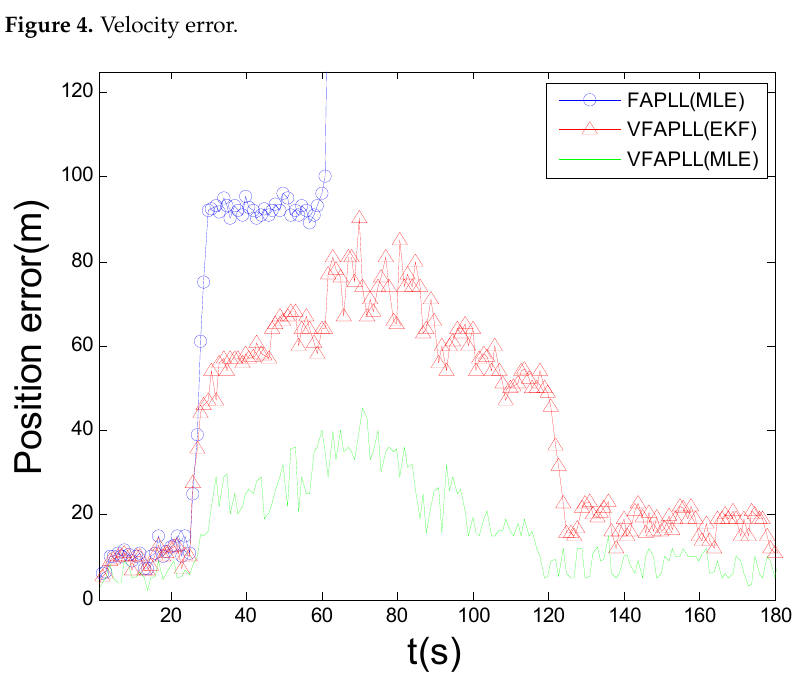
Figure 4. Velocity error.